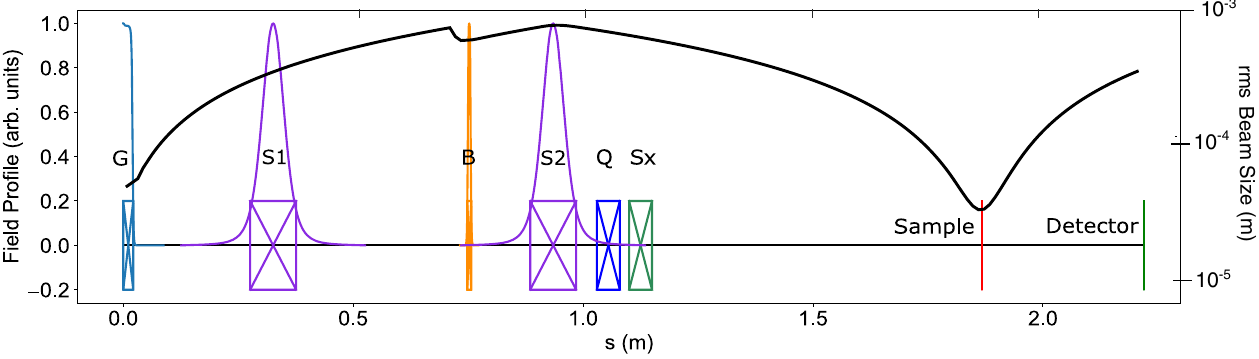
FIG. 1. A schematic of the MEDUSA ultrafast electron diffraction beamline, including the 140-keV dc electron gun (G), solenoids (S1 and S2), 3-GHz bunching cavity (B), quadrupole (Q), and sextupole (Sx) correctors. The plot shows element locations and the normalized longitudinal field profiles (left axis) where applicable. The right axis and black curve show the evolution of the horizontal rms beam size in logarithmic scale for a typical space-charge simulation with 8 fC at the sample plane. The emittances and phase spaces measured in this paper are measured at the sample location. The probe-defining aperture mentioned in the text is not included in this